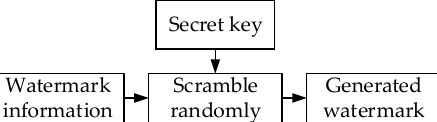
Figure 4. The general model of watermark generation.